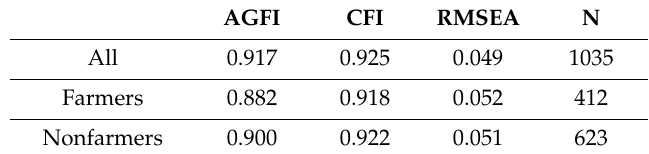
Table 2. Di ff erent goodness for fit indices of the results of covariance structure model analysis. AGFI CFI RMSEA N All 0.917